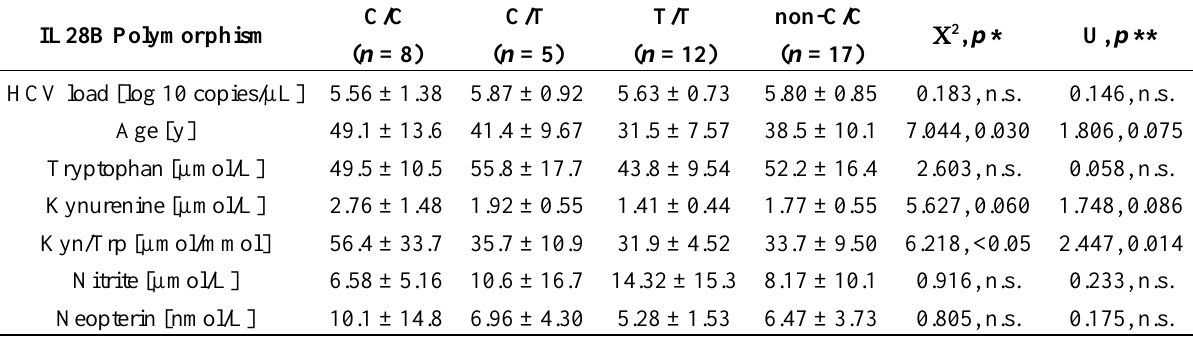
Table 2. HCV load, tryptophan, kynurenine, nitrite and neopterin concentrations as well as the kynurenine to tryptophan ratio (KYN/TRP) in patients with HCV infection grouped according to IL-28B polymorphisms (mean ± S.D. are shown; n.s. = not